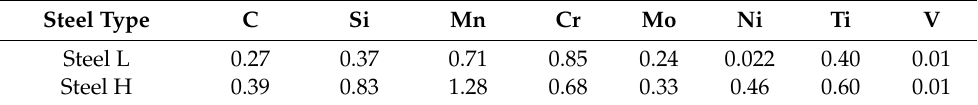
Table 1. Chemical composition of steels studied in this project